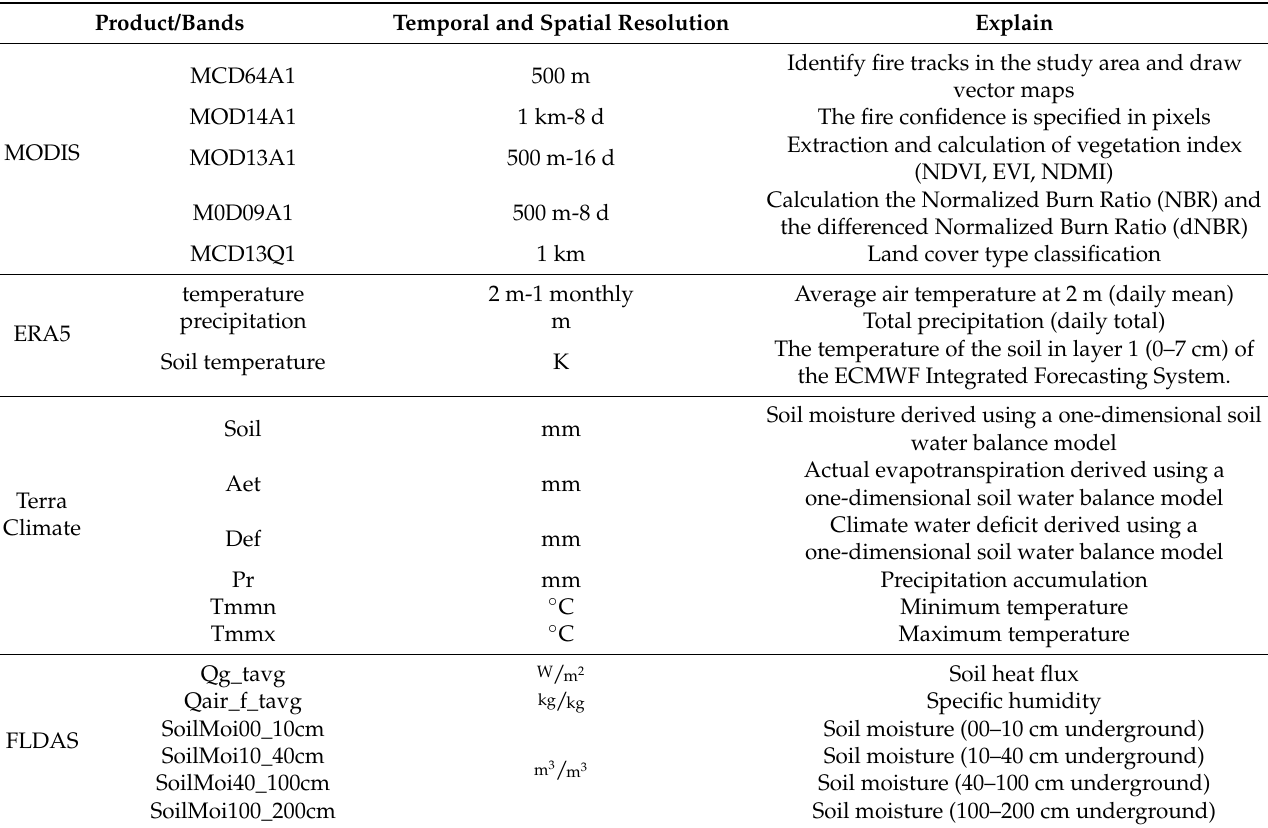
Table 2. Dataset used in this